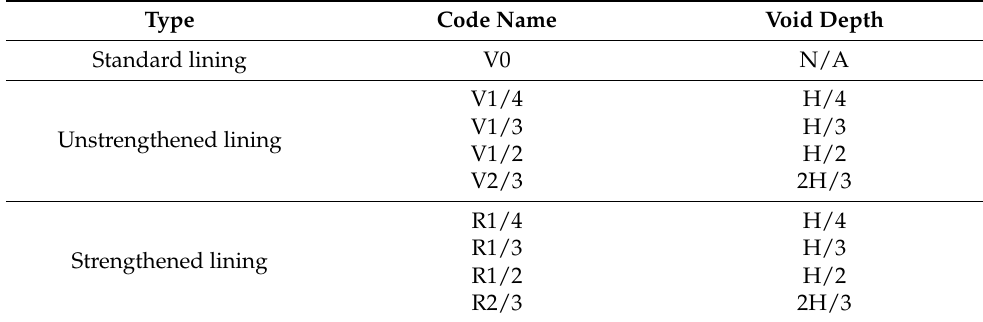
Figure 3. Installation of the steel plate. Table 1. Details of the specimens.